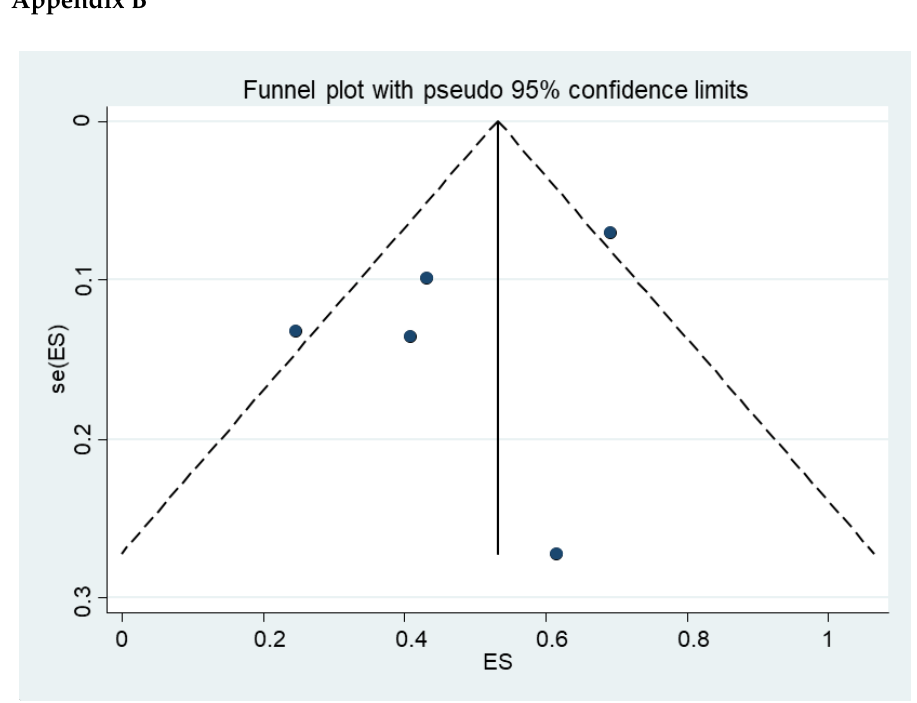
Figure A1. Funnel plot from the meta-analysis of intervention completers.